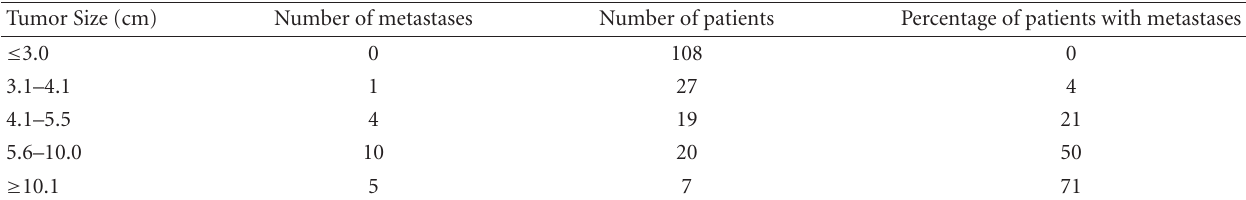
Table 2: Comparision of tumor size and metastaes (adapted from Du ff ey et al.